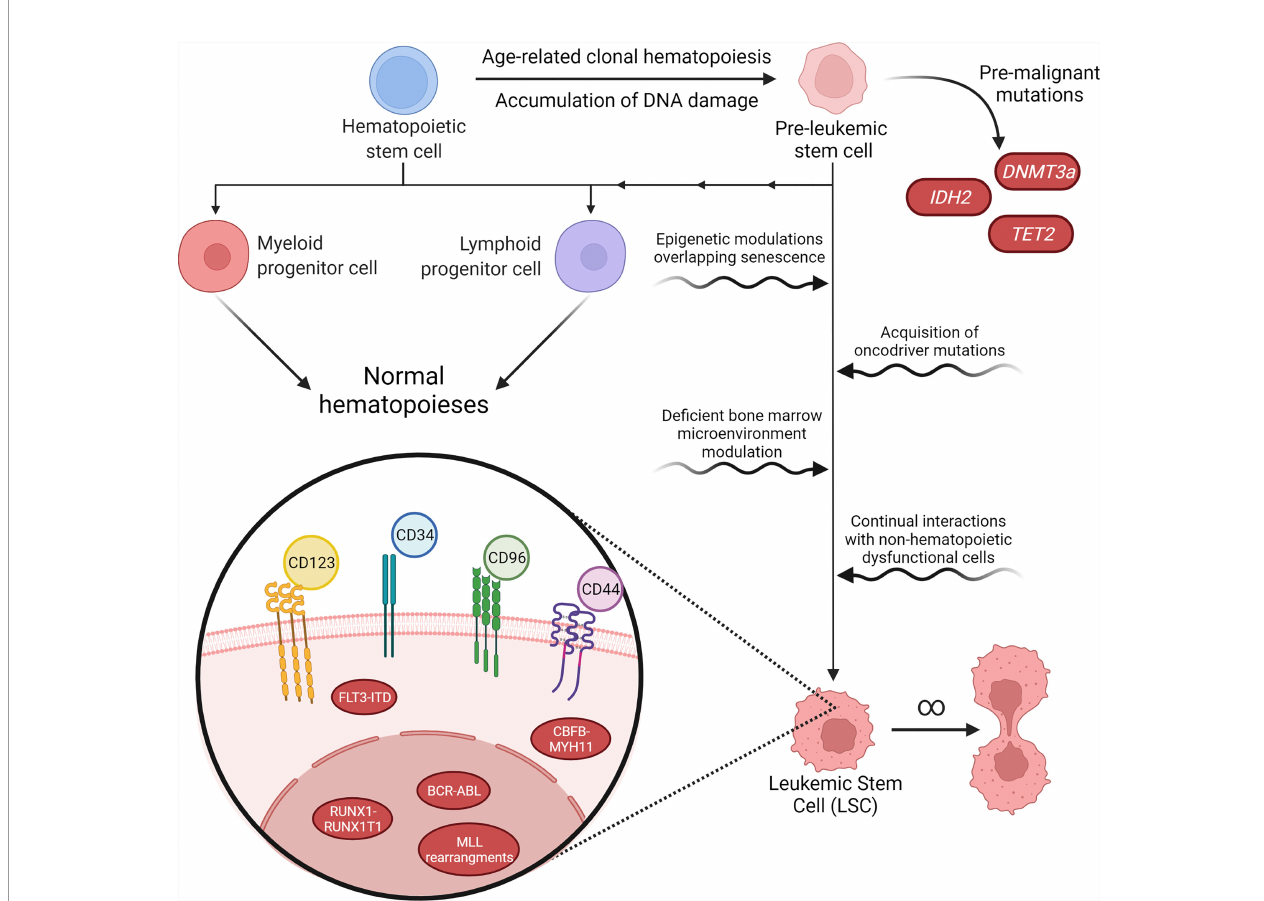
FIGURE 1 | Pathways of malignancy in hematopoiesis and its characteristics. Aging and exposure to hazardous environmental agents lead to accumulation of DNA damage and mutations in hematological precursor cells, inducing a pre-leukemic stem cell (pre-LSC) phenotype. Pre-LSCs acquire proliferation advantages over normal hematopoietic stem cells (HSCs) due to mutations in genes such as DNA methyltransferase 3 alpha ( DNMT3a) , but still retain their capacity to promote normal hematopoiesis. However, further malignant characteristics acquired over the years may tip these cells into a proper leukemic stage. The transformation of pre-LSCs may happen through cell-speci fi c processes, such as epigenetic modulation or new acquired mutations, or through interactions between these cells and their microenvironment, through changes in the normal growth and survival signaling pathways or due to interactions with dysfunctional stromal or mesenchymal cells that are also present in the bone marrow. After malignancy onset, leukemic stem cells (LSC) may present a variety of karyotype rearrangements, such as BCR-ABL or FLT3-ITD , that determine their malignant characteristics and tend to present immunophenotyping pro fi les that still resemble normal HSCs, such as CD34 + 38 - , while also overexpressing a cohort of cell-surface antigens that are highly variable between patients and even among different cell populations in the same